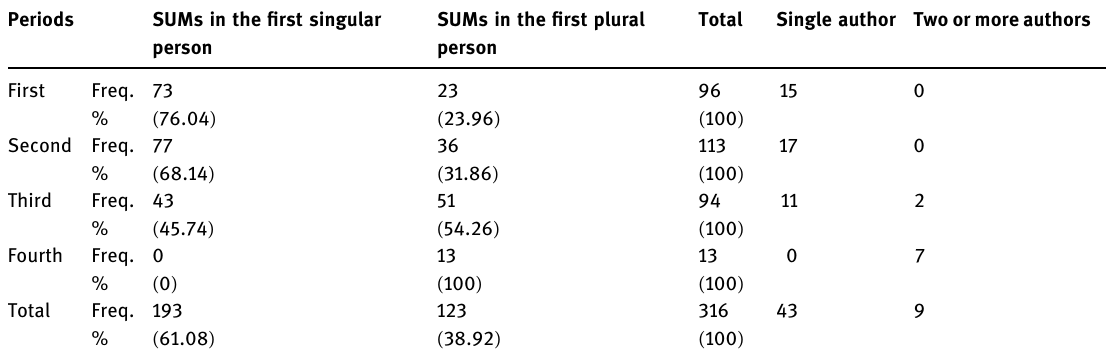
Table 14: SUMs in the fi rst singular and plural person in the whole corpus and in each time period